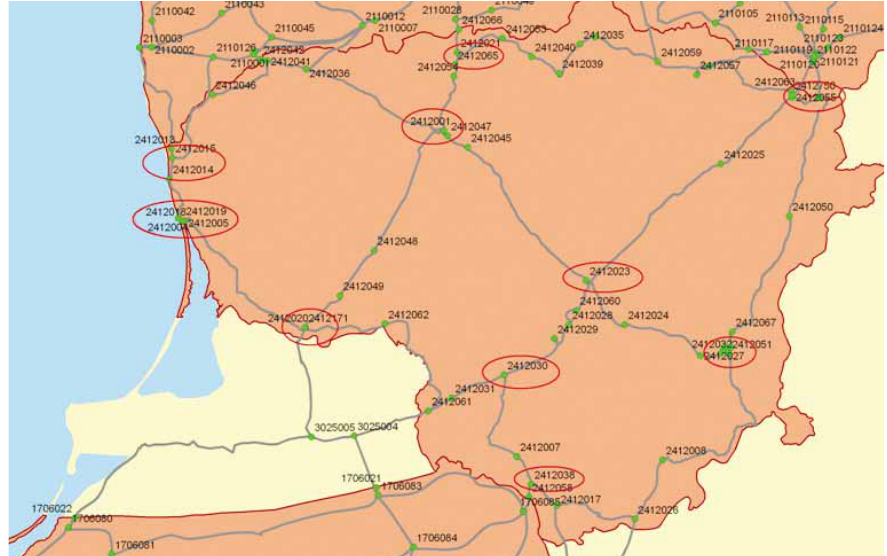
Fig. 3. The Lithuanian NGVN in UELN (red ellipses show the datum points of the